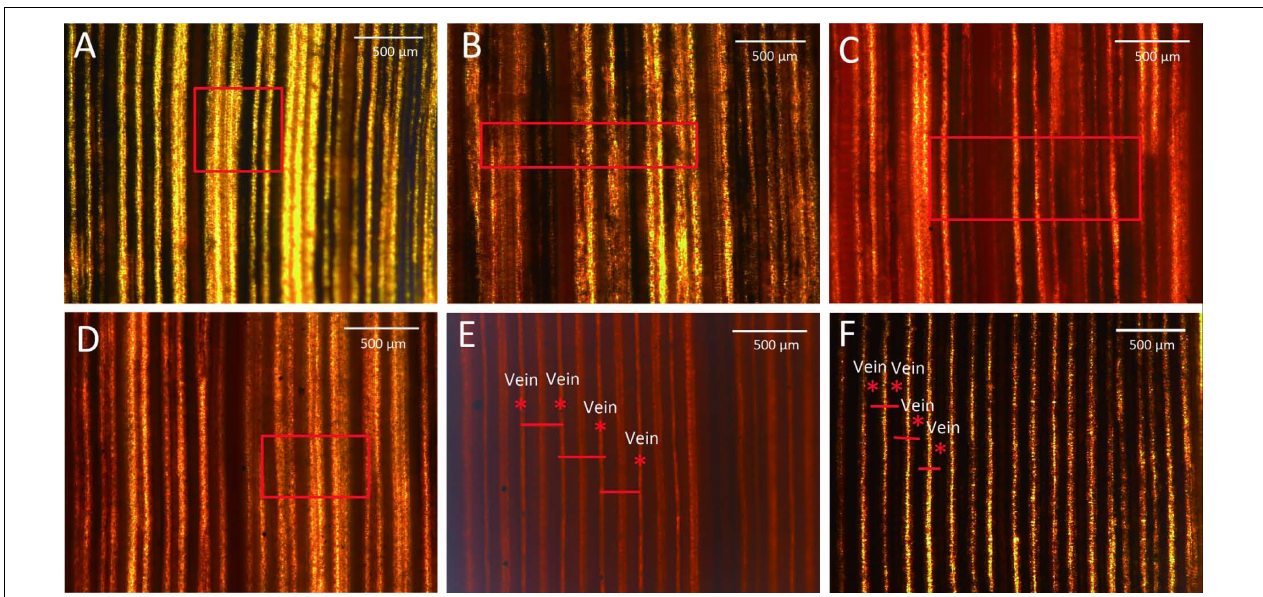
FIGURE 3 | Leaves stained with I 2 -KI. (A) Decreased carbohydrate abundance and normal vein arrangement ( t62 ); (B) decreased carbohydrate abundance and abnormal vein arrangement ( t95 ); (C) increased carbohydrate abundance ( t66 ); (D) unevenly stained ( t74 ); (E) rice (C 3 control plant); and (F) wild-type Yugu1. Scale: 500 µ m. Leaf veins are marked with an asterisk, and short red lines represent the distance between adjacent leaf veins. The red boxes in the picture means obvious differ between mutants and wild-type